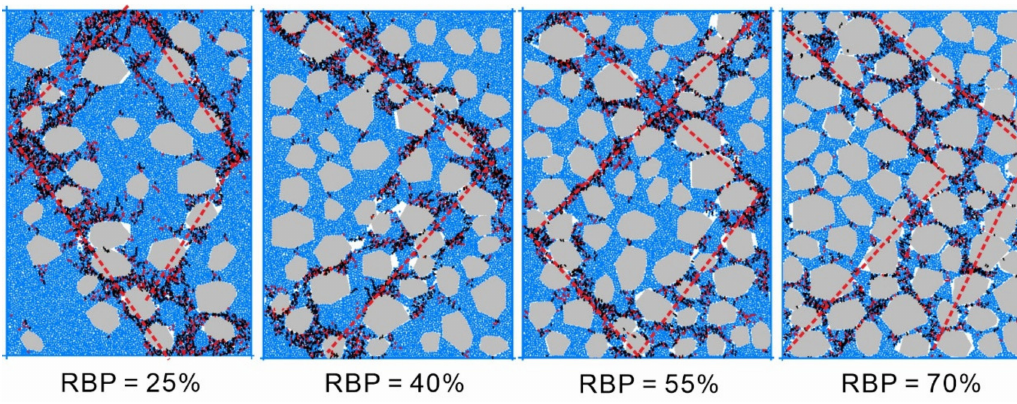
Figure 8. Morphology of shear failure of